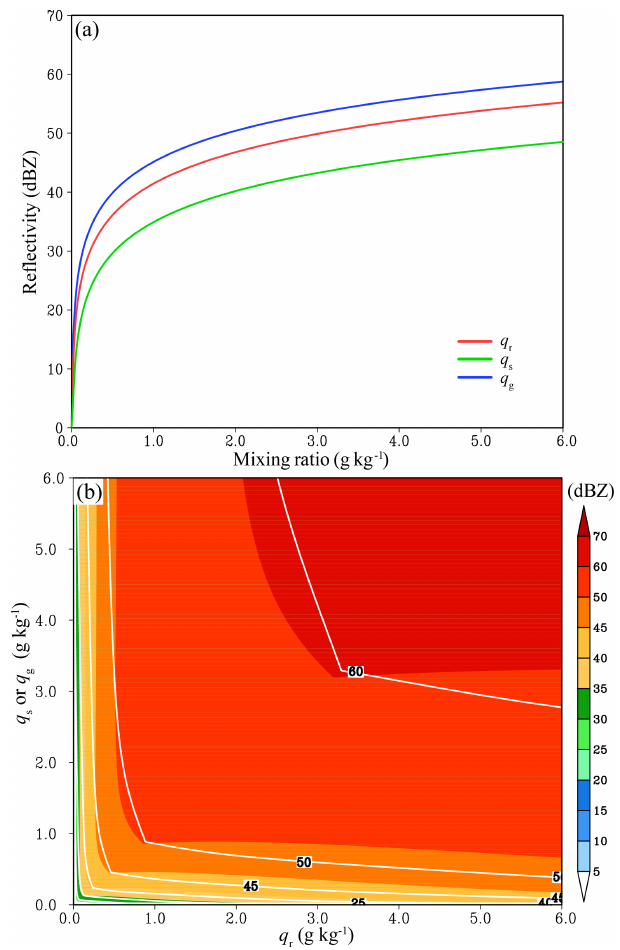
Figure 1. (a) The reflectivity as (a) a function of q r (red), q s (green), and q g (blue) for pure water and dry snow/graupel and (b) a function of q r – q s (colors) and q r – q g (contours) for wet snow/graupel.